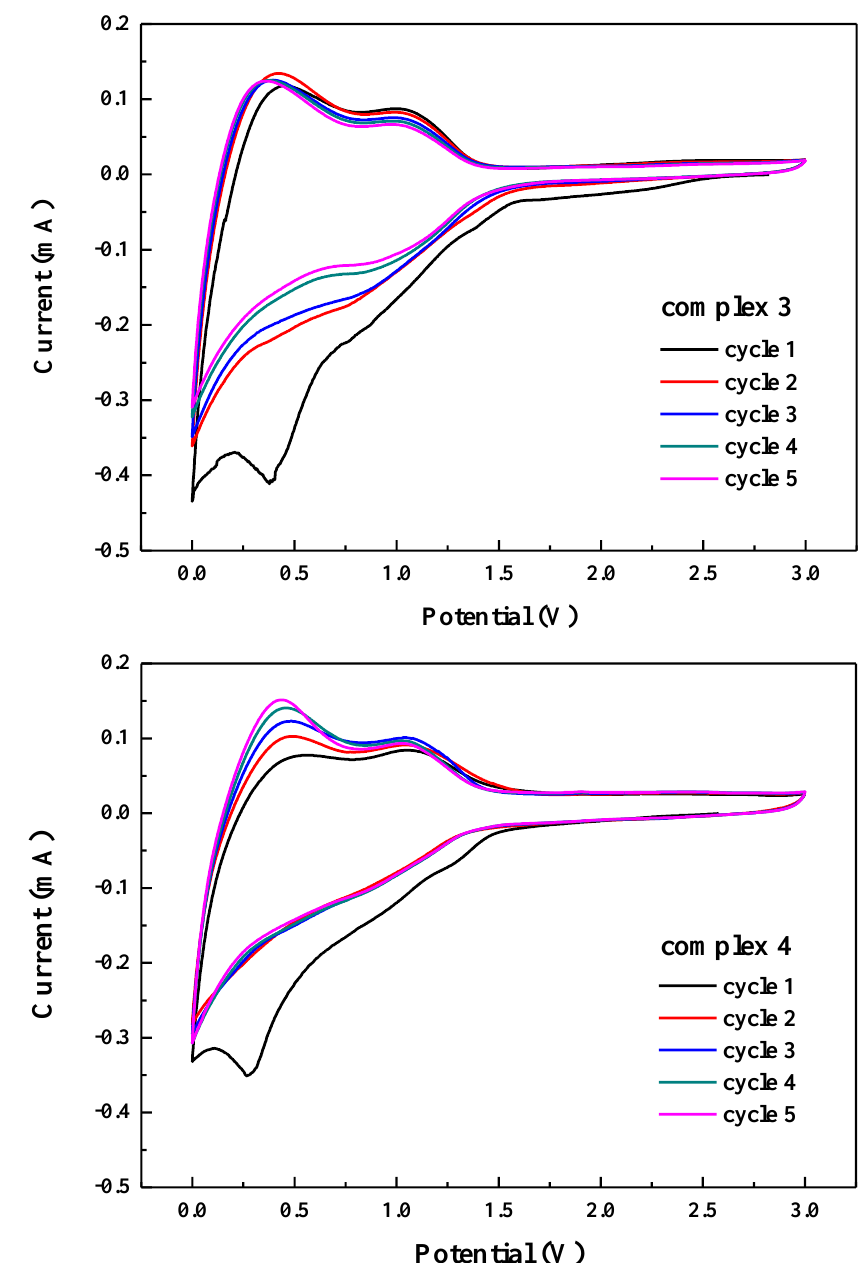
Figure 6. Cyclic voltammograms of complexes 3 and 4 in 1M LiPF 6 EC/DMC (1:1 V / V ), which was recorded in the first five cycles at a scanning rate of 1 mVs −1 .